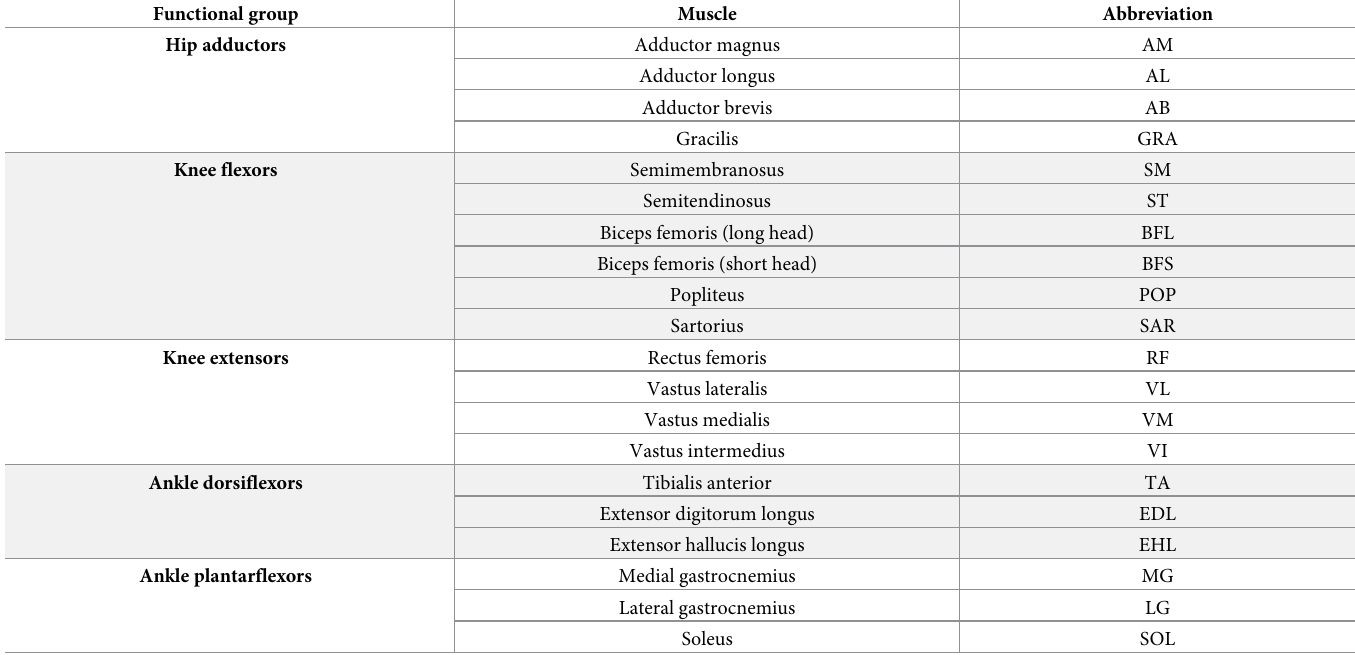
Table 2. Muscle functional group classifications, based on those from Ward et al.,